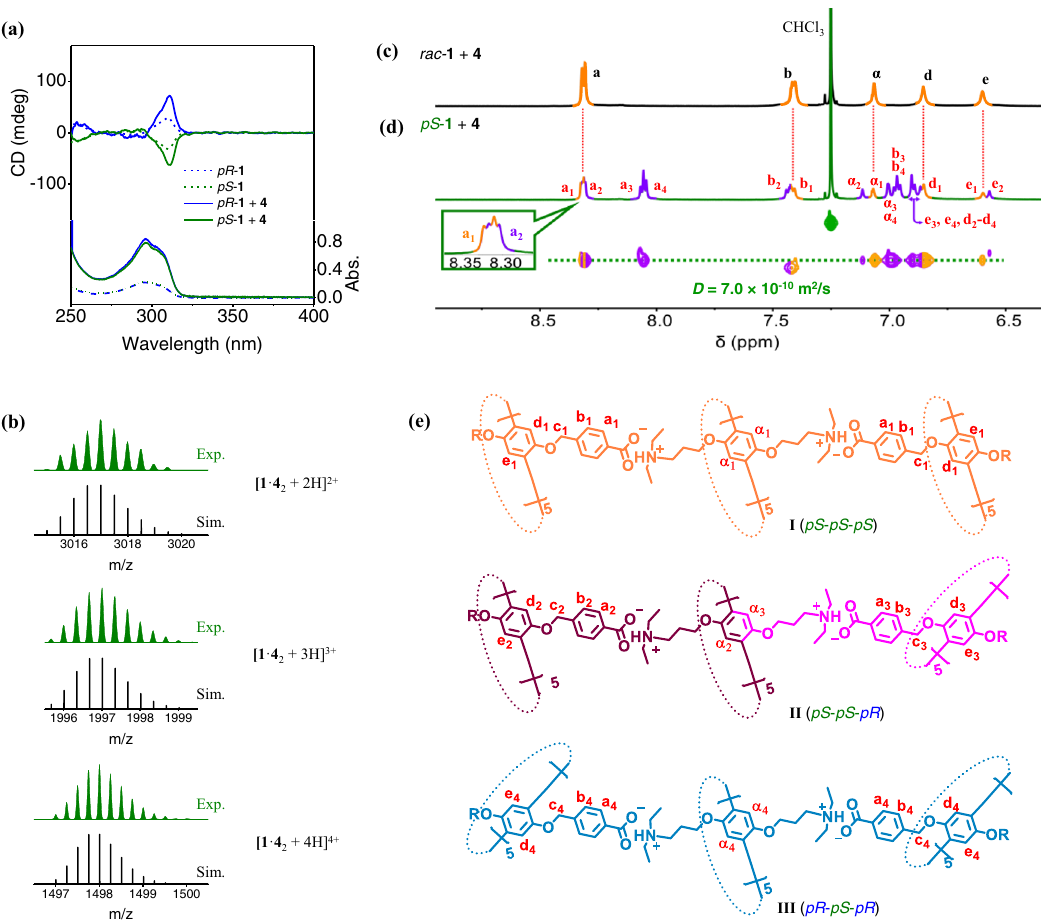
c rac - 1 and 4 ,and d pS - 1 and 4 .TheDOSYNMRspectrum(500MHz,CDCl 3 ,25°C)of theas-preparedmixtureof pS - 1 and 4 isalsoshownin d .Forall 1 HNMRspectra,the concentrationsof 1 and 4 were0.5and1.0mM,respectively. e Molecularstructures of the three trimers in the mixture of pS - 1 and 4